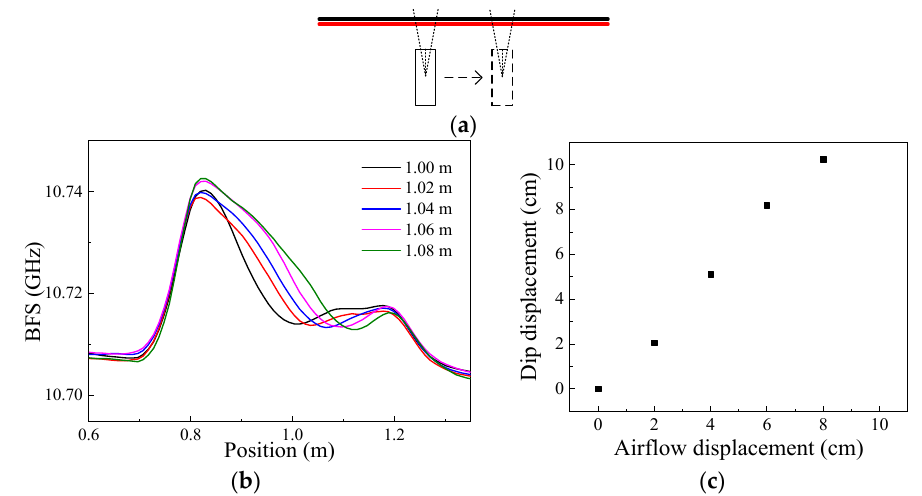
Figure 4. Schematic diagram and measurement results for transverse movement of the airflow: ( a ) Schematic diagram for transverse movement of the airflow; ( b ) BFS distributions for different airflow positions; ( c ) The demodulation result.